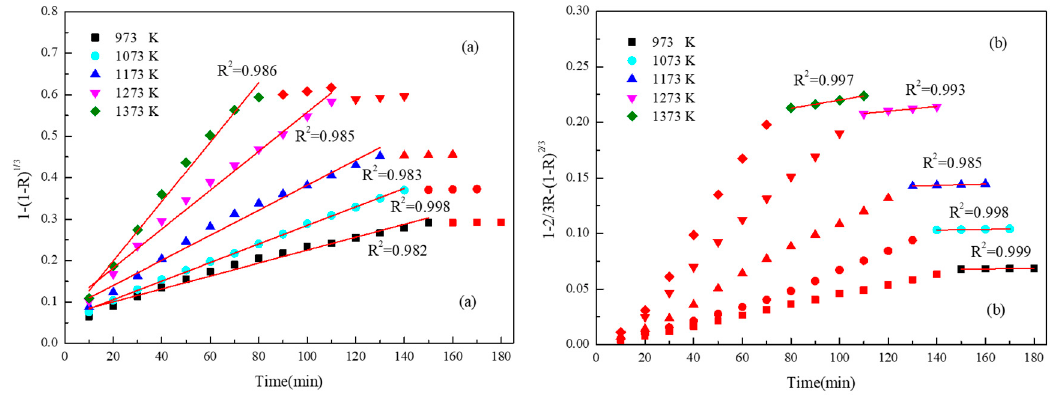
(cid:3117) (cid:3119) vs. time ( a ) and plot of 1 −